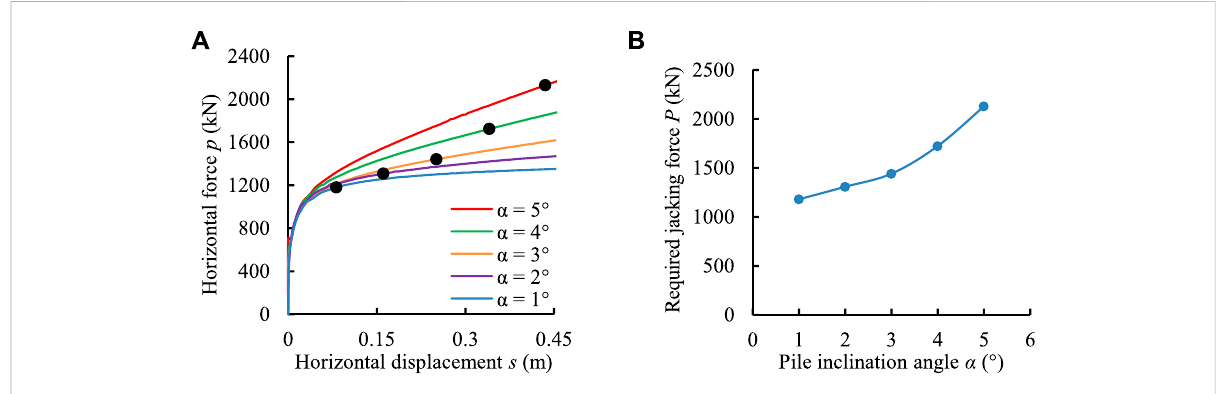
FIGURE 7 Theeffectofpileinclinationangle α ontherequiredhorizontalforce P (Case1): (A) Variationofhorizontalforce p withhorizontaldisplacement s at the pile top with different pile inclination angles α and (B) Variation of the required horizontal force P with α .